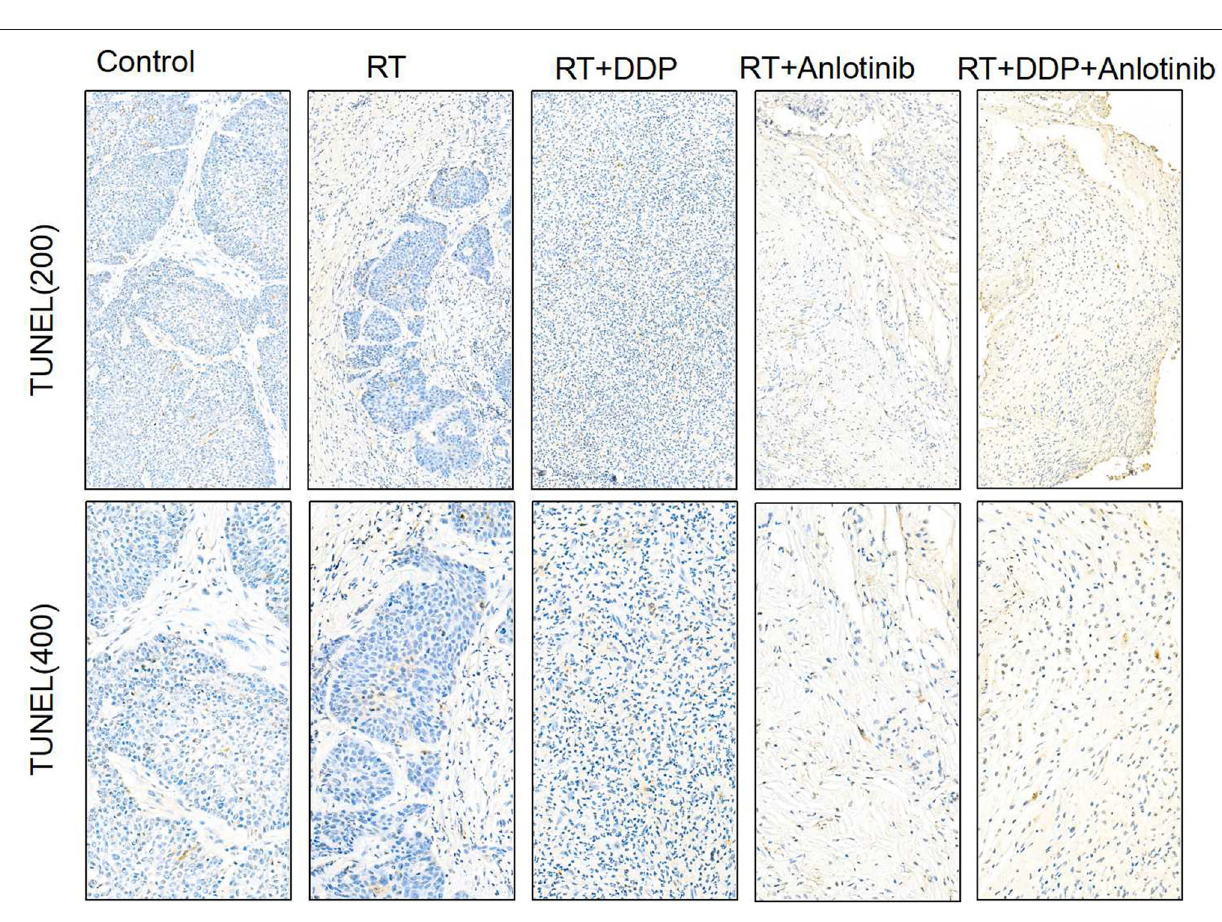
for the proliferation marker PCNA were significantly decreased in the treated tumor masses compared with the normal saline-treated tumor masses, and anlotinib combined with chemoradiation treatment resulted in the lowest PCNA levels